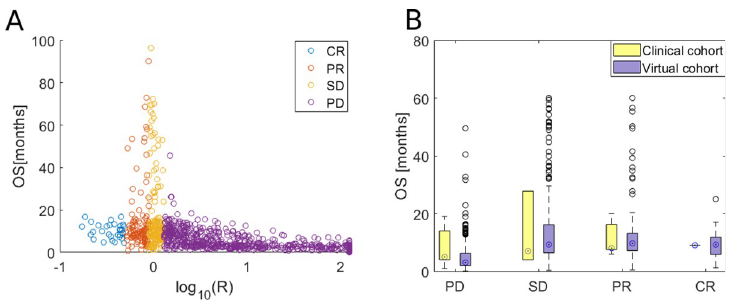
Fig 4. Long-term response to palliative platinum-doublet chemotherapy as a function of initial response. A) Initial response (R; log-transformed tumor reduction after treatment) versus long-term response (OS; overall survival in months) to platinum doublet chemotherapy in virtual cohort. Patients are divided into four groups CR (complete response), PR (partial response), SD (stable disease) and PD (progressive disease), based on the initial response